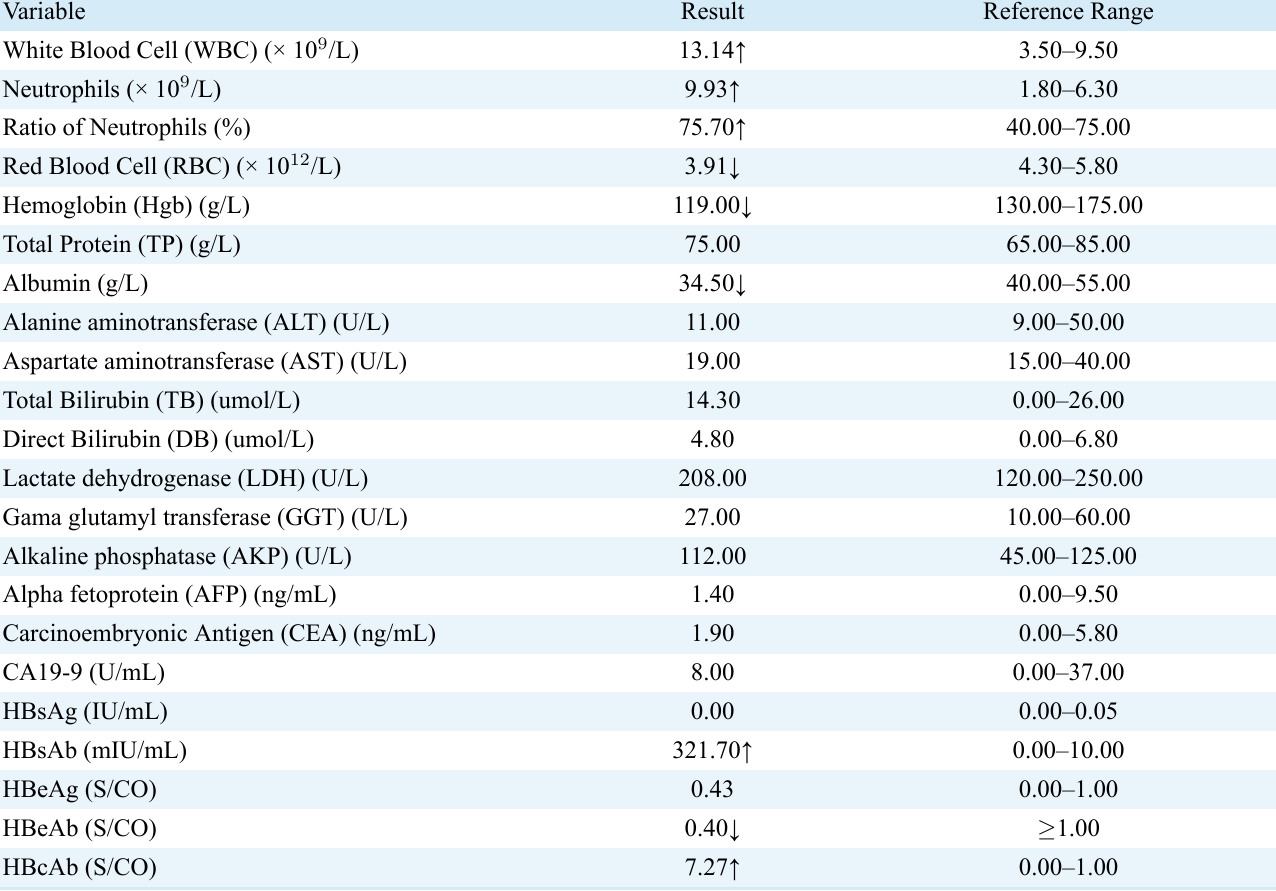
TABLE 1. Laboratory